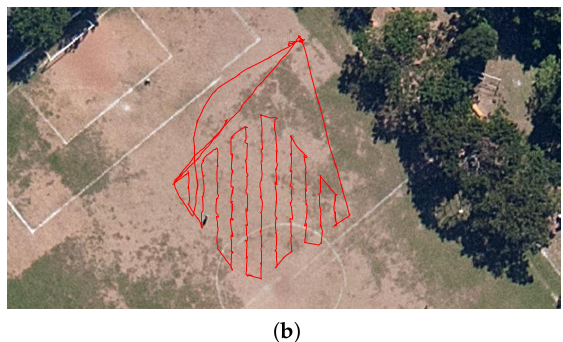
Figure 15. Field experiment survey path. ( a ) The planned path with a 2 m separation between survey points on an area of 381 m 2 . The red dots are the survey points where the robot hovers ( t h = 7 s), and the red rectangle the position of the artificial anomaly; ( b ) The real executed trajectory of the robot on red.